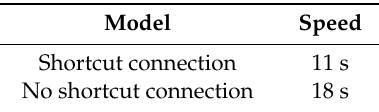
Table 5. Data processing speed with or without shortcut connections.